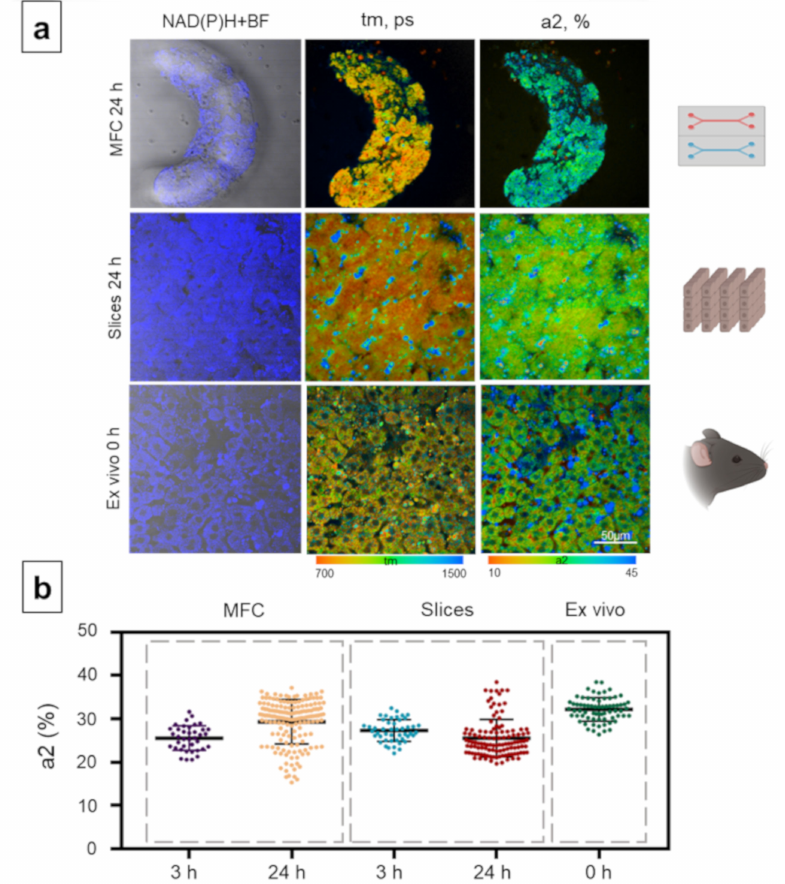
Figure 3. Metabolic imaging of control mouse hepatocytes with the MFC, slice and ex vivo models. ( a ) Combined images of the bright-field and the autofluorescence of NAD(P)H (left row)